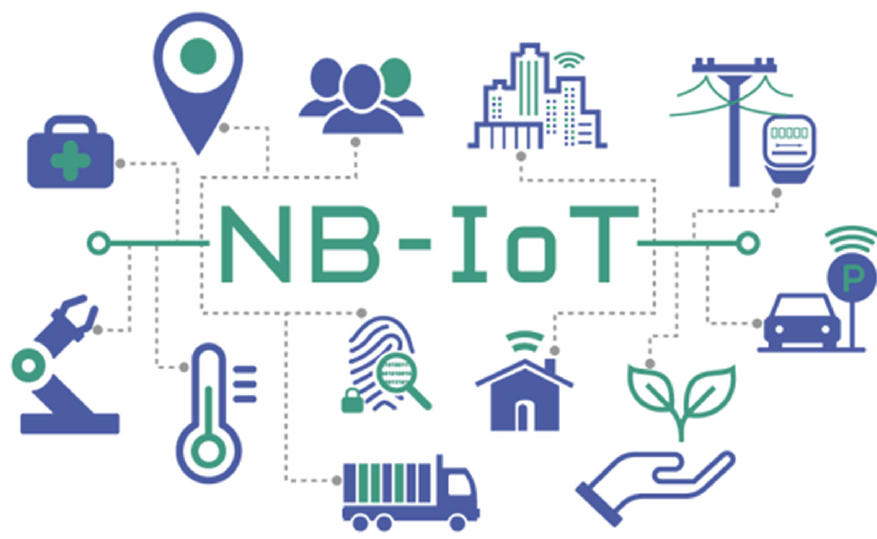
Figure 1. Examples of NB-IoT applications.